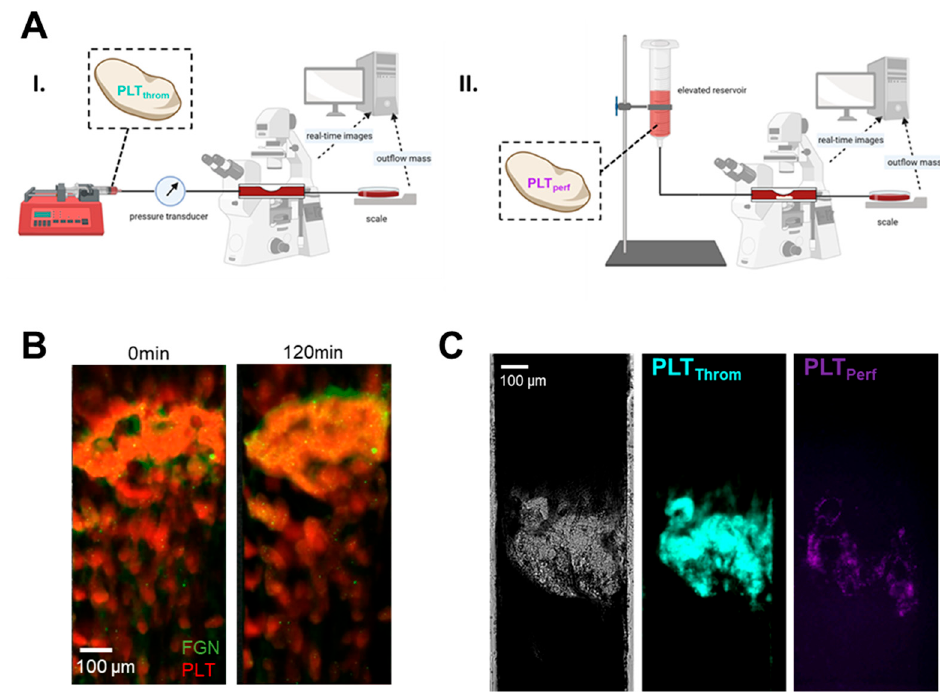
Figure 4. Microfluidic reperfusion experiments. ( A ): I. Partial occlusion is induced in a controlled flow setting in a microfluidic stenosis (initial wall shear rate at the throat 3500 s − 1 ; target pressure increase 25 mmHg). Platelets in this sample are labelled aqua (PLT throm ). II. Reperfusion is initiated with a treated sample using the syringe pump and low flow. Once the treated sample reaches the testbed a constant arterial pressure head is induced using gravity to simulate in vivo flow conditions (i.e., true occlusion). Platelets in the reperfusion sample are labelled purple (PLT perf ). Created with BioRender.com, accessed on 21 October 2022. ( B ): Control thrombus with platelets stained red and fibrin(ogen) (FGN) stained green, immediately post occlusion (0 min, left) and after 120 min (right). ( C ): Representative images during perfusion in II. At left, grayscale transmitted light. Center, aqua PLT throm . Right, new purple deposition of PLT perf .